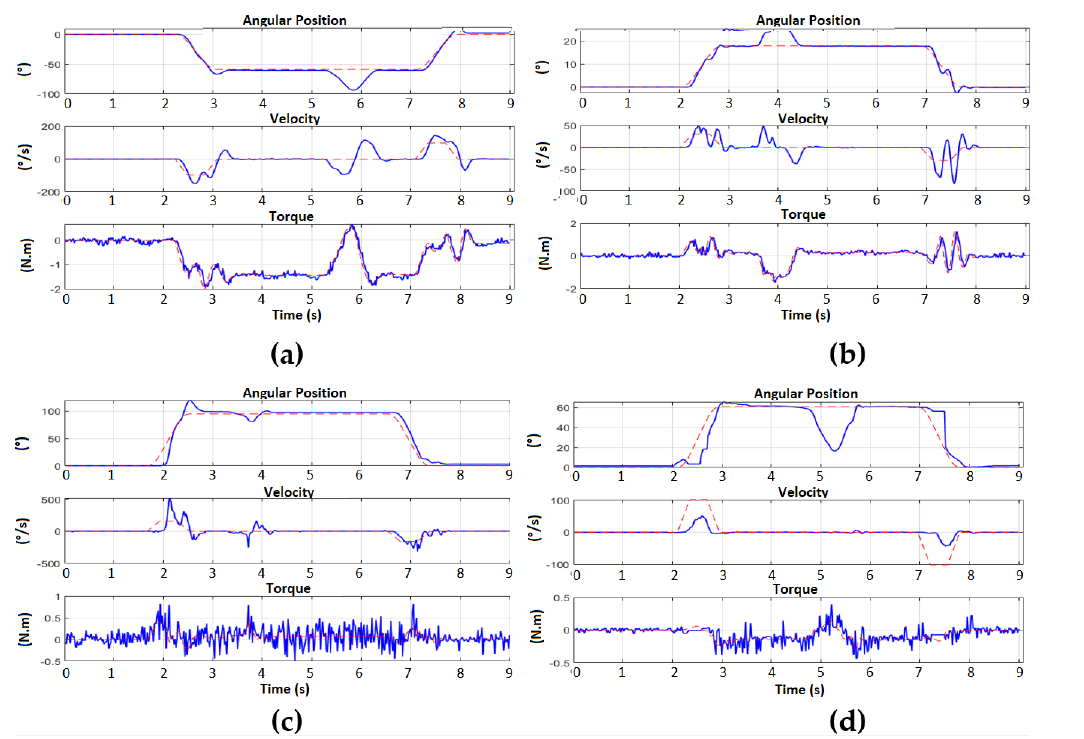
Figure 24. Position and speed regulation with subsequent disturbance. ( a ) Motor 1 from 0 ◦ to − 59 ◦ ; ( b ) Motor 2 from 0 ◦ to 18 ◦ ; ( c ) Motor 3 from 0 ◦ to 61 ◦ ; ( d ) Engine 4 from 0 ◦ to 97 ◦